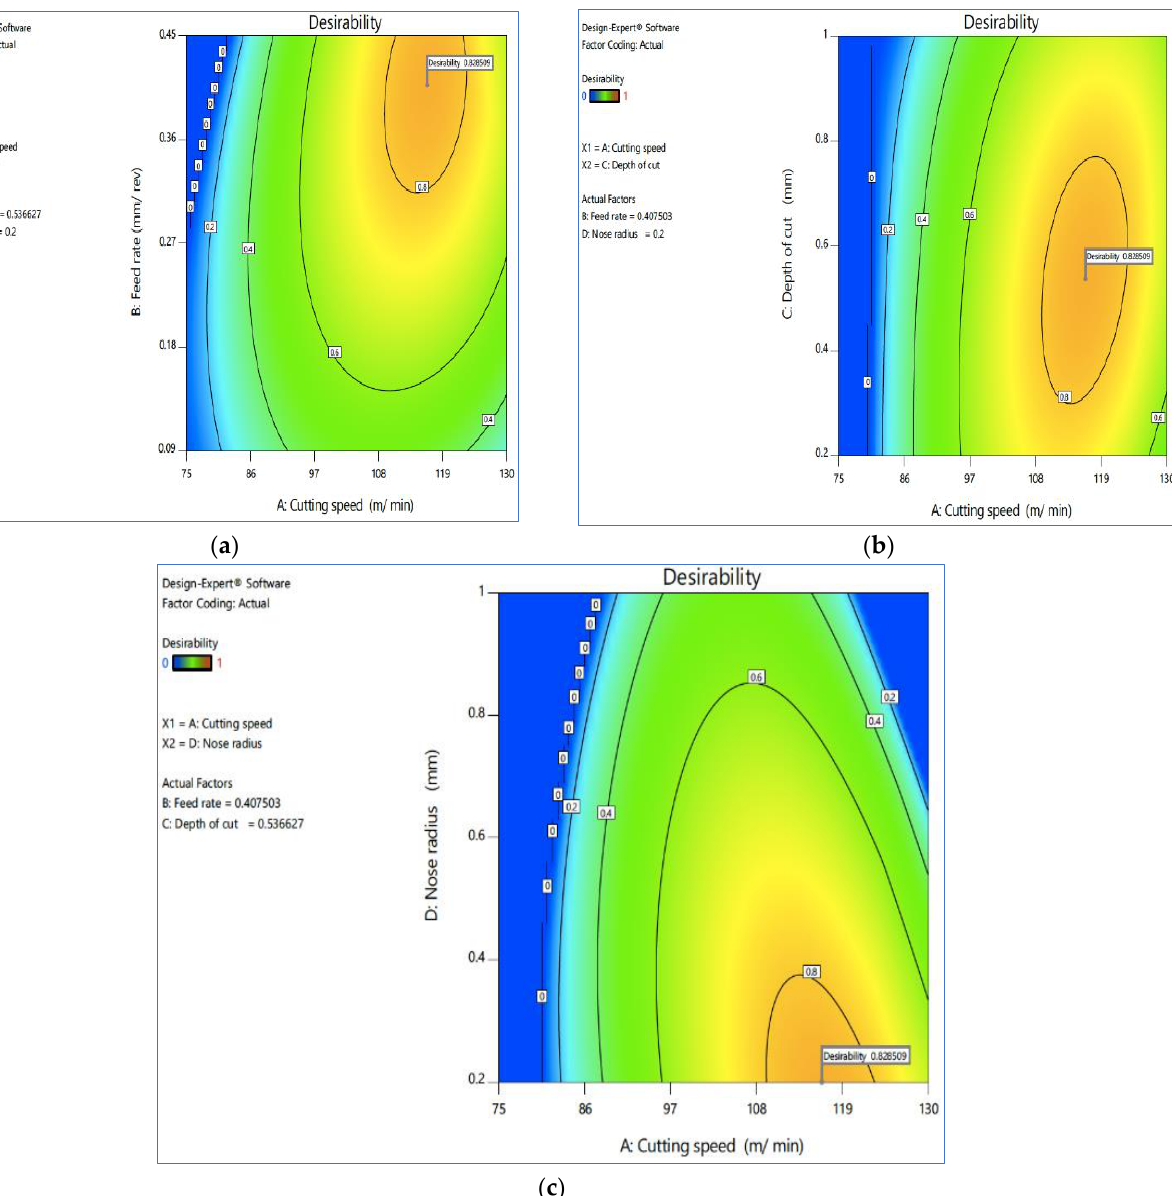
Figure 6. Contour plot on desirability for ( a ) V c vs. F z , ( b ) V c vs. D c and ( c ) V c vs. R n . Plots produced using Design-Expert software V11 (StatEase, Minneapolis, MN, USA).